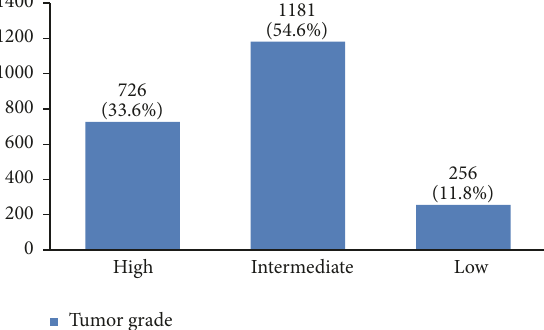
Figure 24: The involved breast sides (left or right) in the studied cases.